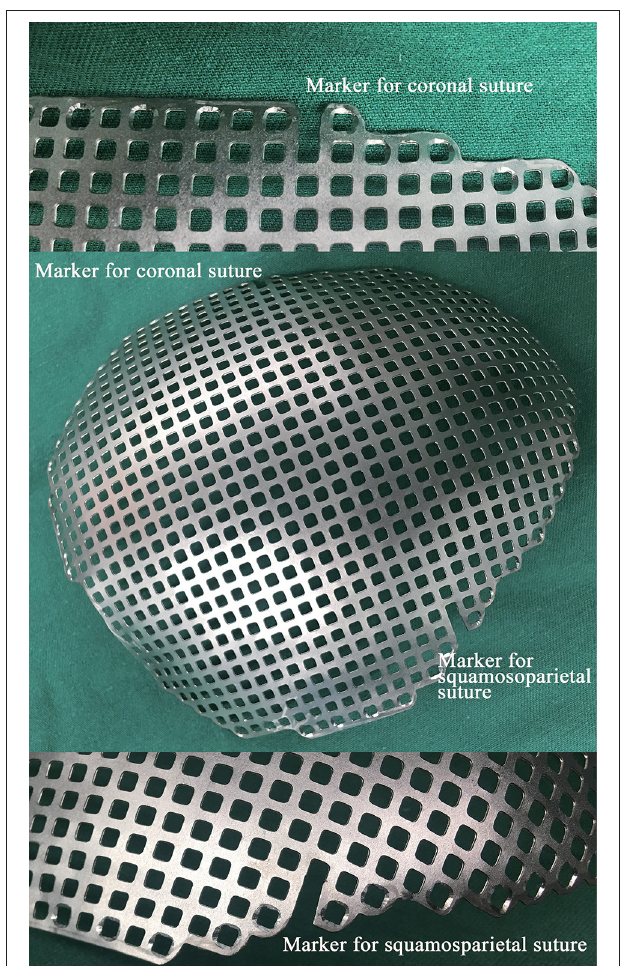
FIGURE 1 | A photograph of a 3D titanium mesh with the anatomical positing markers. 3D,